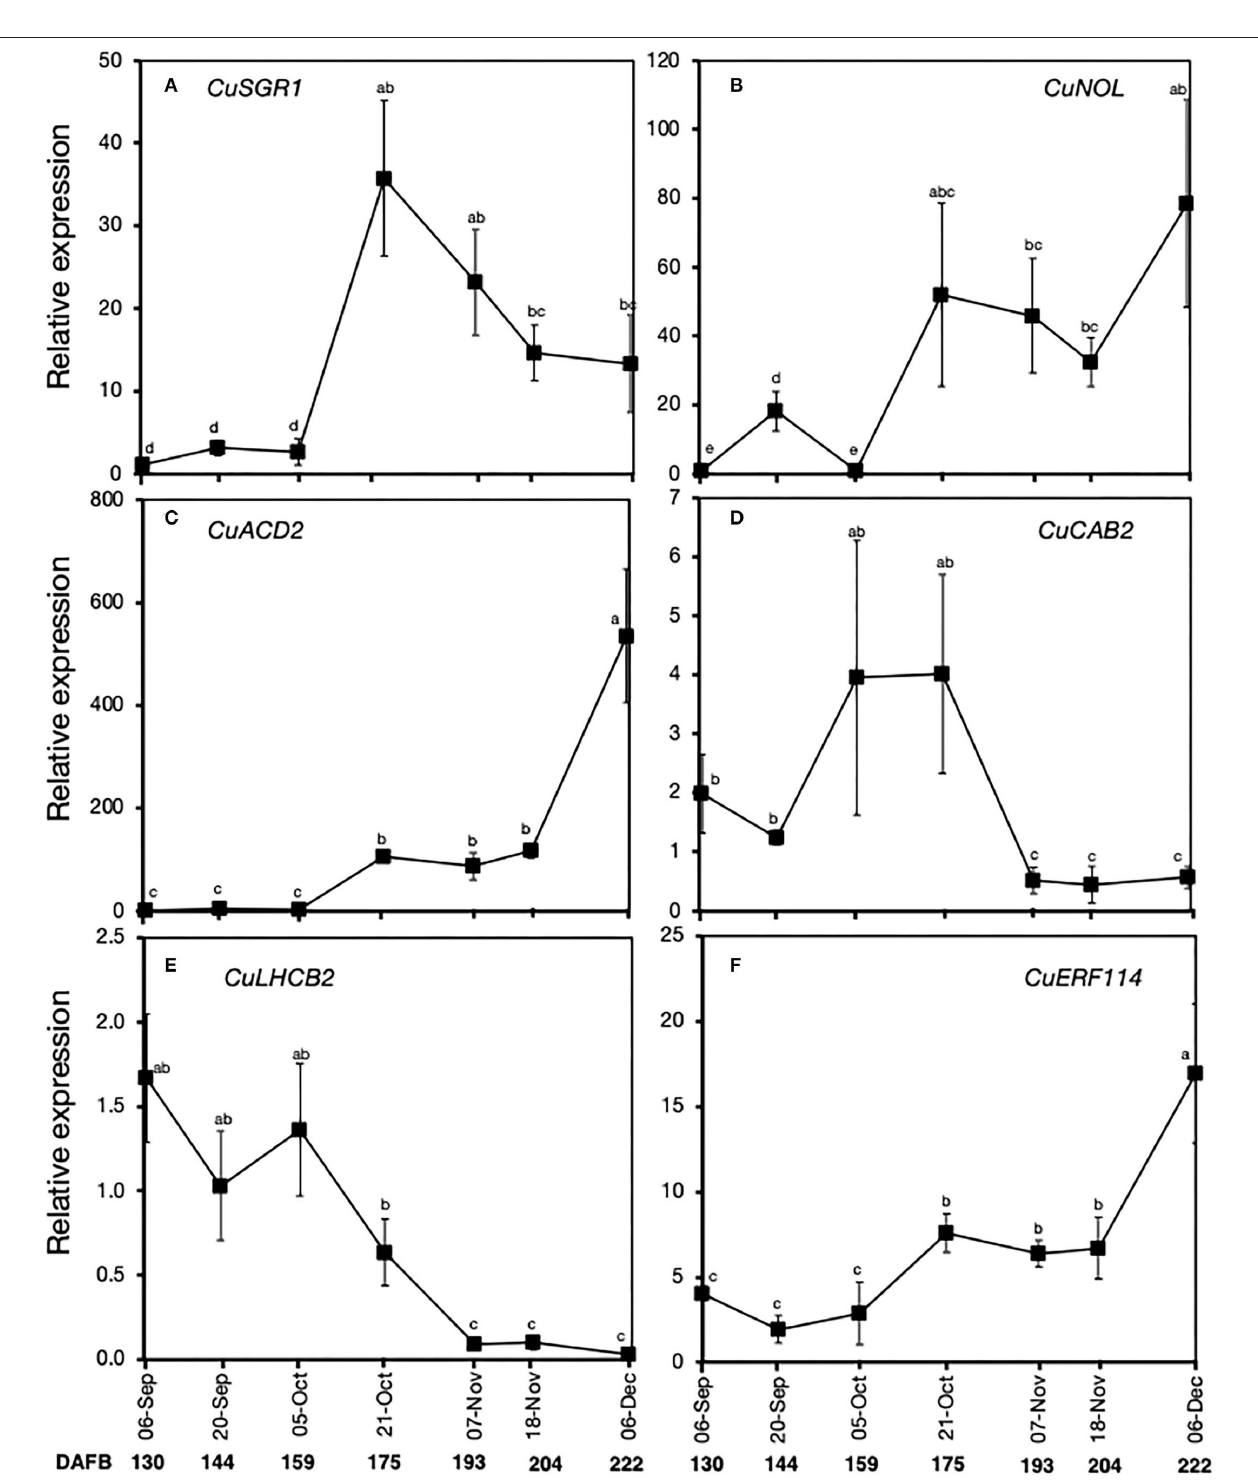
FIGURE 6 | Relative expression levels of selected genes associated with chlorophyll degradation and a transcription factor in the flavedo of Satsuma mandarin fruit during on-tree peel degreening. Values below the horizontal axis indicate the average minimum environmental temperature recorded on the specified date. (A) CuSGR1 ( Ciclev10021651m .g), (B) CuNOL ( Ciclev10008039m .g), (C) CuACD2 ( Ciclev10026248m .g), (D) CuCAB2 ( Ciclev10016286m .g), (E) CuLHCB2 ( Ciclev10016280m .g), and (F) CuERF114 ( Ciclev10032575m .g). Data points represent the mean ( ± SE) of three fruit and different letters indicate significant